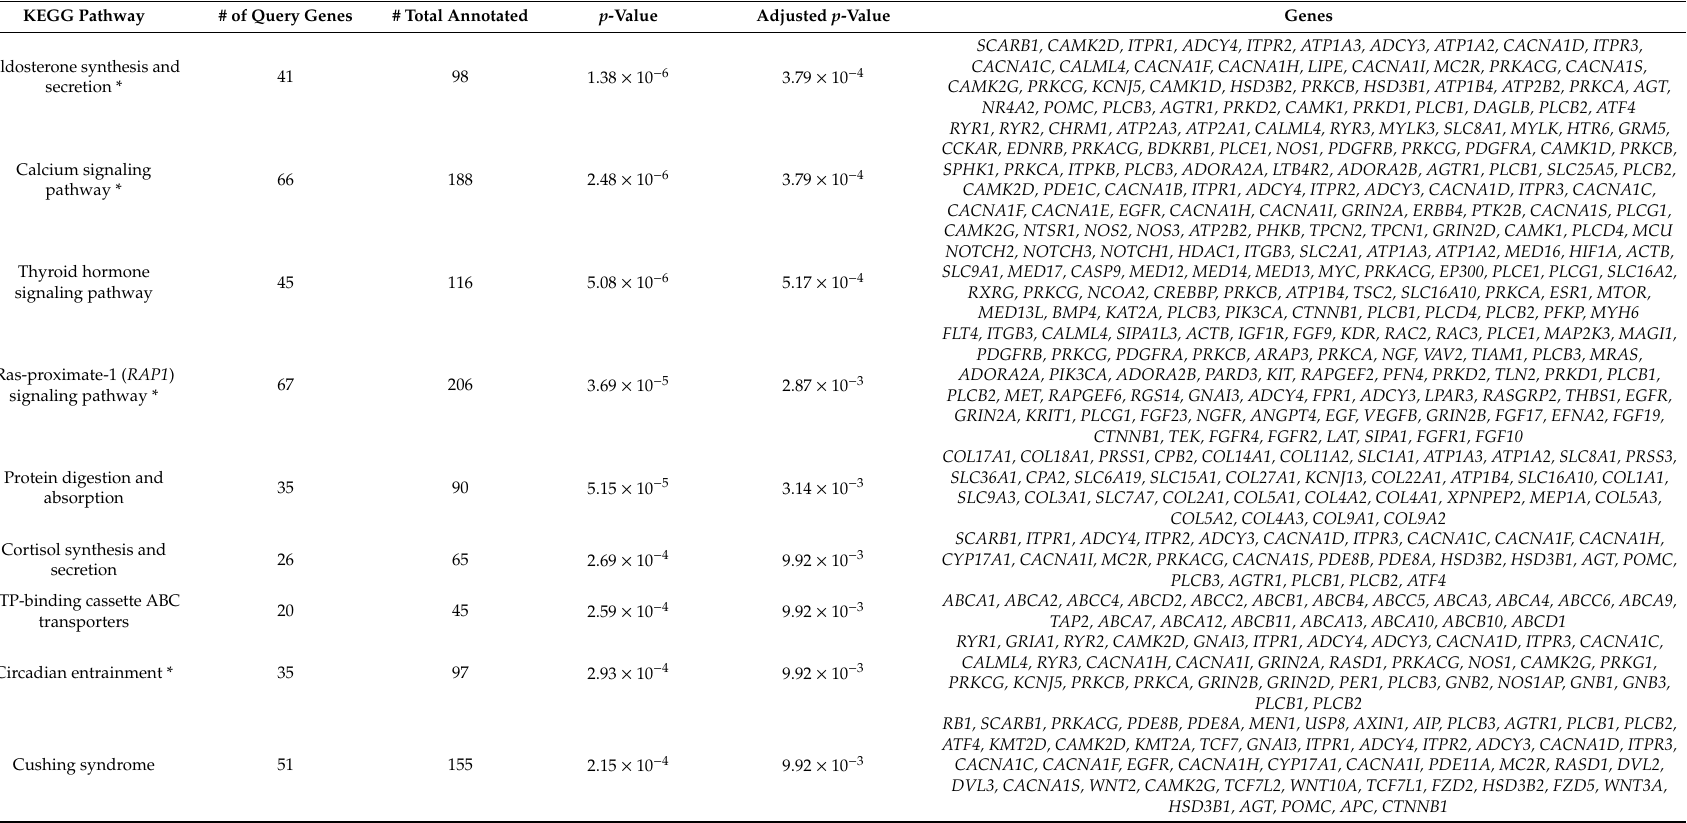
Table 1. Enrichment analysis of KEGG pathway annotations for secondary genes with somatic